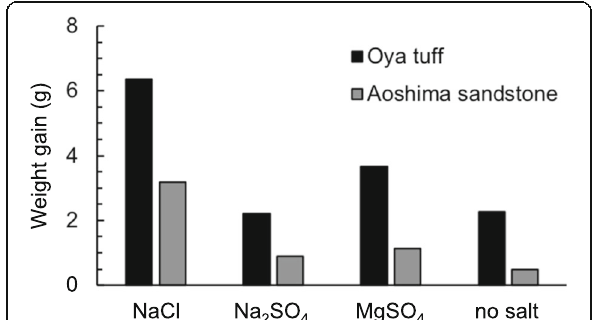
Fig. 3 Weight gains in the first high-humidity period. The value represents the amount of water absorbed into specimens during the high-humidity conditions. The specimens with NaCl showed the largest absorption. The specimens with MgSO 4 showed greater gains in weight than the specimens with Na 2 SO 4 or without